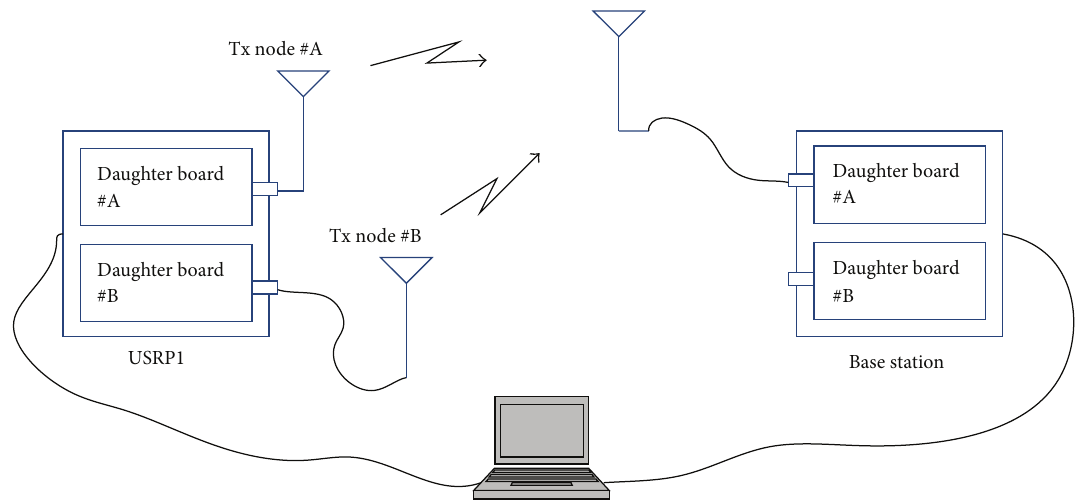
Figure 10: Configuration of measurement for received signal power.